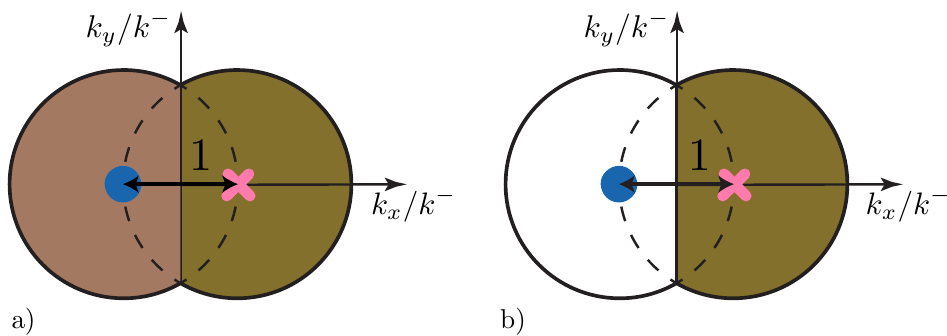
Figure 8 . The catchment area of nonperturbative modes kept relevant for a) shift and b) boundary terms at LL, in the respective boosted frame, as pictured from above looking down the jet axis (taken along the z -direction). These modes are clustered with either the collinear subjet located on the jet axis (blue dot), or the stopping collinear-soft subjet (pink cross) as indicated by the shaded brown regions. The overlapping circles both have radius 1 for the given choice of